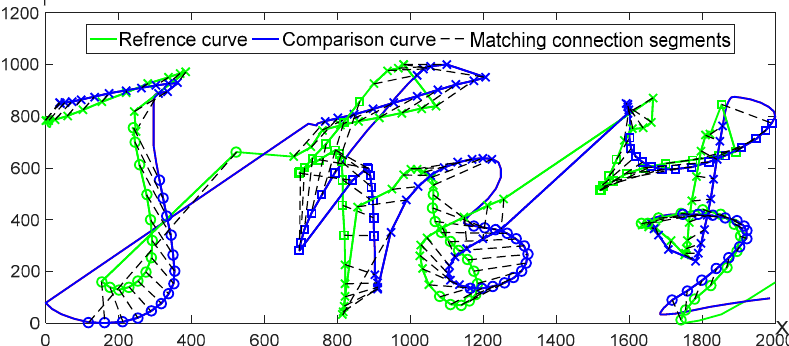
Figure 6. The matching result of X and Y curves between two genuine signatures.